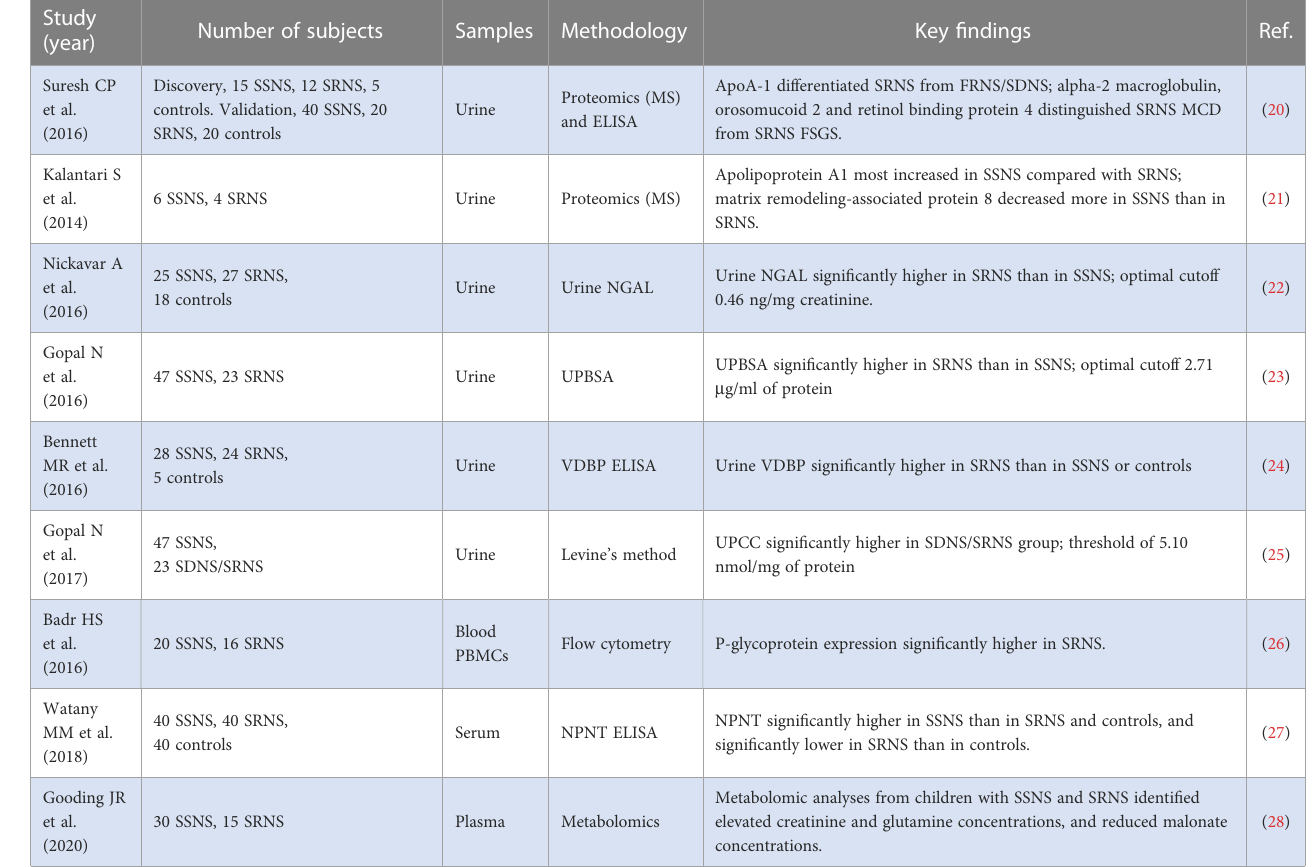
TABLE 1 Biomarkers in urine and blood that distinguish between SSNS and SRNS. Study Number of subjects Samples Methodology Key fi ndings Ref. (year)